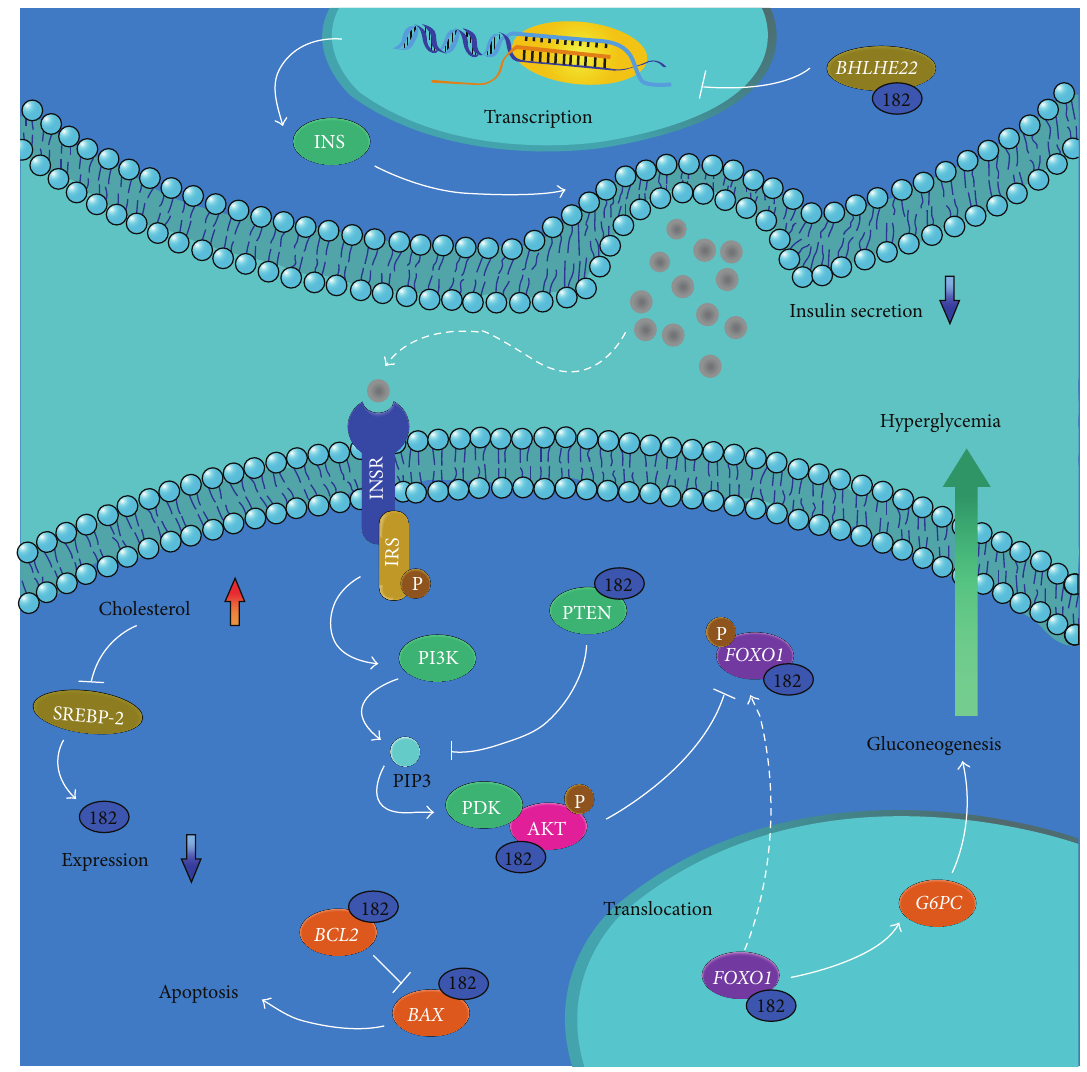
Figure 3: Putative regulation network of miR-182 related to the syndrome in T2D. The miR-182 can be linked to the syndrome of T2D according to the valid target genes analysis. The crucial genes and pathways that related to insulin resistance, insufficient insulin secretion, and the impairment of the tissues were represented in the